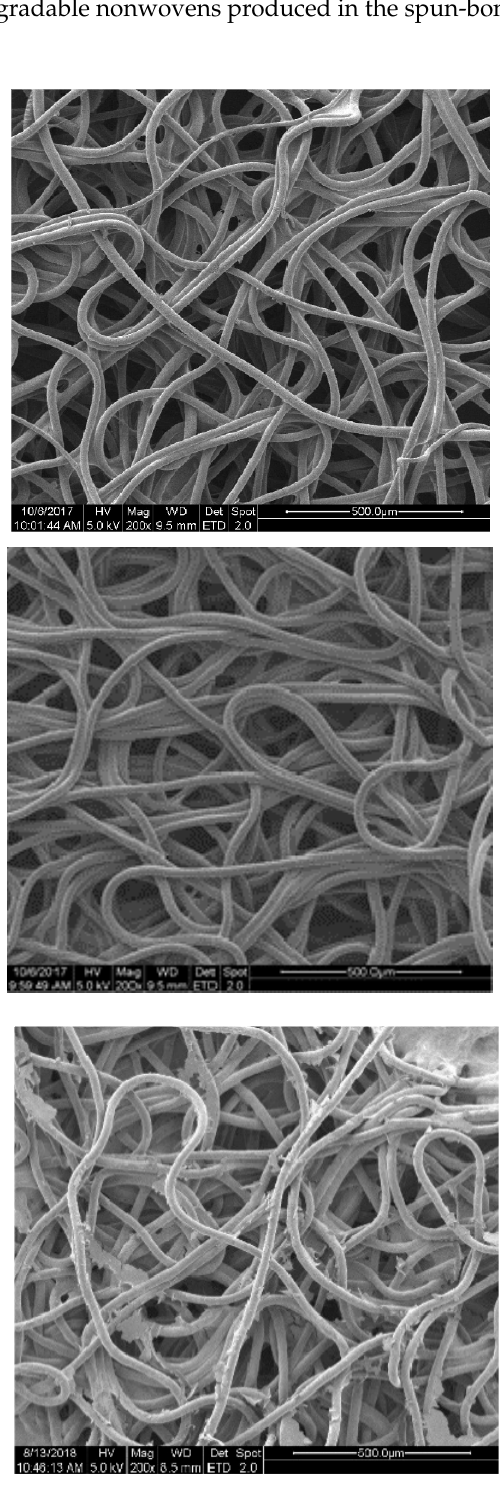
Figure 1. Difference in fiber diameter in spun-bond and meltblown technology.